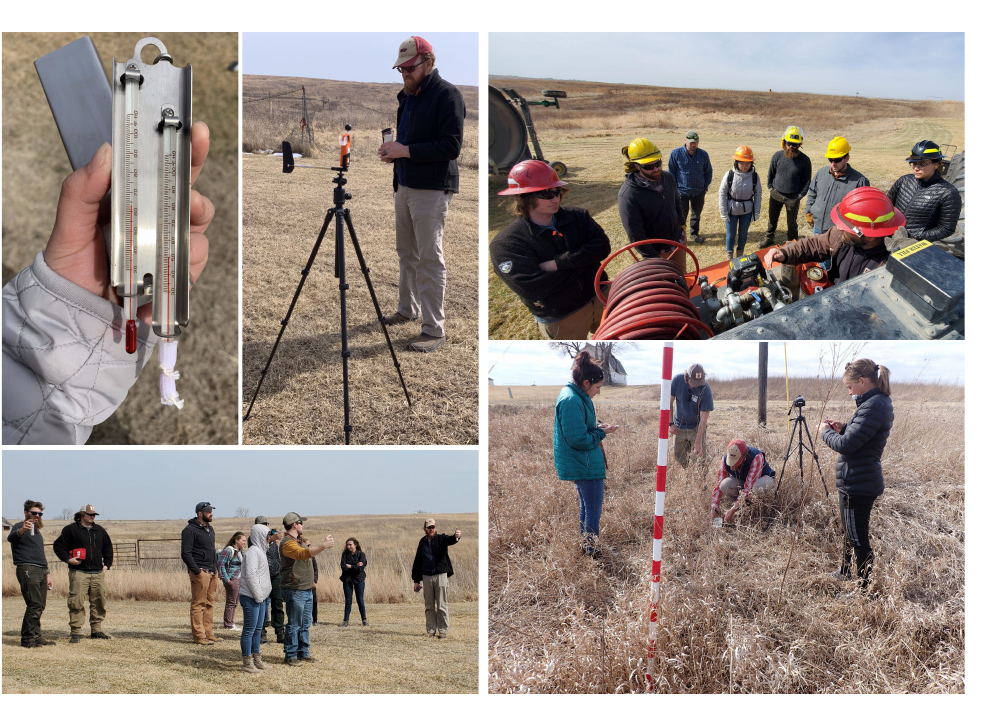
Figure 5. The first day of the workshop was focused on introducing students to the tools they would be using and training them on safe and effective operation ahead of live fire. Participants were introduced to measuring fire weather with both the Belt Weather Kit and automated weather stations, pump operations, and measuring fuel load with both destructive and non-destructive